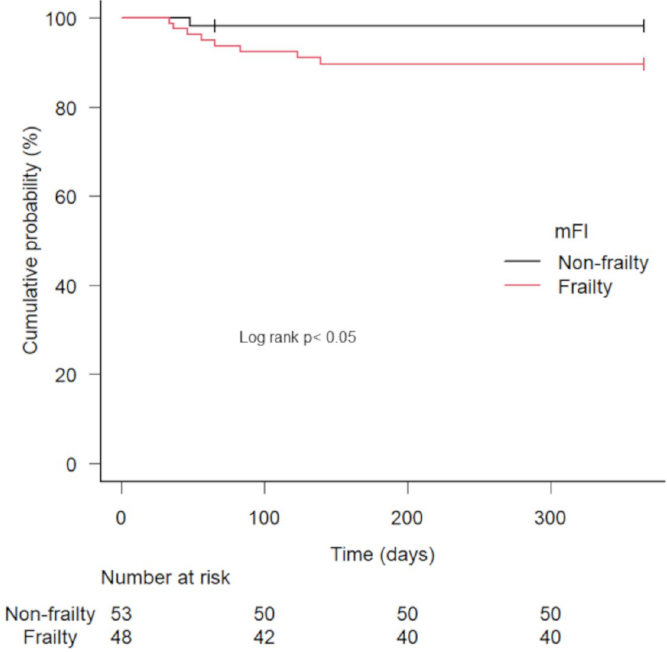
Fig 3. Kaplan-Meier curve comparing time to development for uncompensated heart failure in patients with cardiac implantable electrical devices (CIED), as classified according to frailty condition, adjusted HFrEF, and CIED